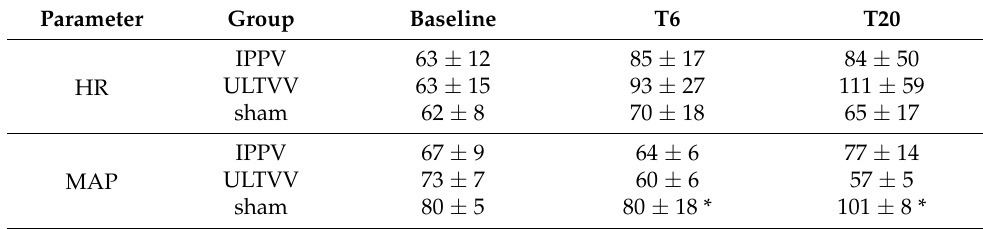
Table 2. Hemodynamic parameters in group comparison. Mean ( ± SD). Group effects over time are analyzed by two-way-ANOVA and with post-hoc Bonferroni correction. There were no inter- group differences at baseline. n(IPPV) = 5; n(ULTVV) = 6; n(sham) = 4. * indicates p < 0.05 in intergroup comparison. HR: heart rate. MAP: mean arterial pressure. CVP: central venous pressure. NA: norepinephrine dosage. CI: cardiac index. Tx: timepoint. IPPV: intermittend positive